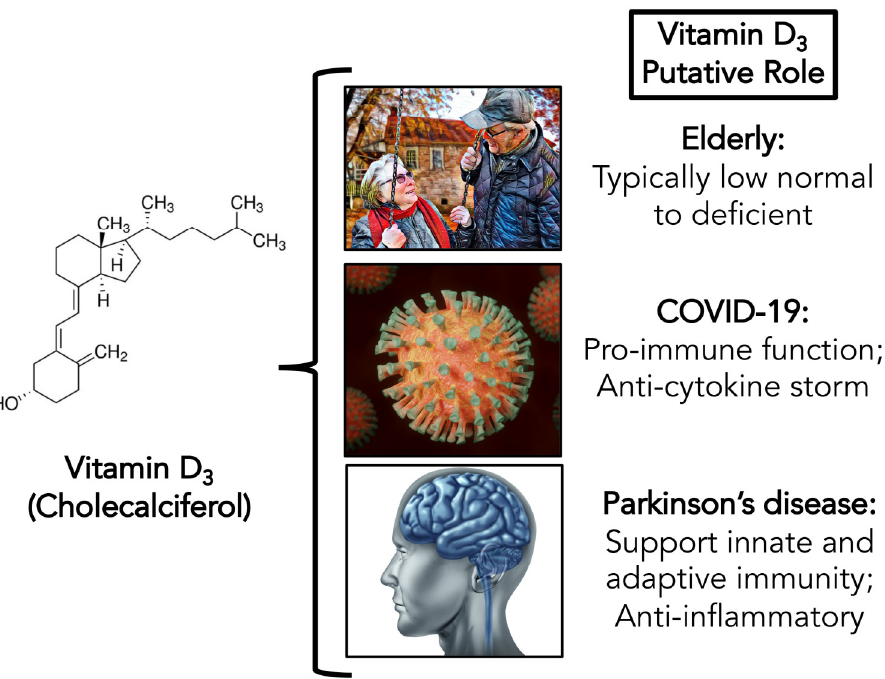
Figure 1. The potential roles of vitamin D 3 supplementation in the elderly, with special consideration to those with Parkinson’s disease and at risk of developing COVID-19.